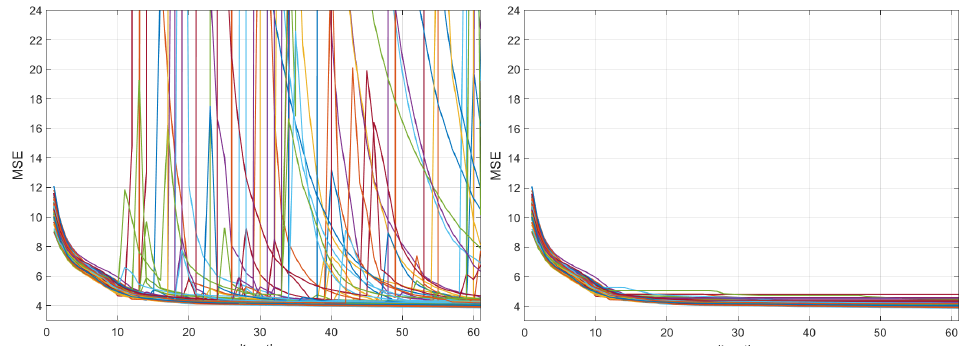
Figure 3. Training MSEs for LBFGS (limited memory Broyden–Fletcher–Goldfarb–Shanno algorithm) on 100 random splits of the abalone dataset, with the different random splits shown in different colors. ( Left ): the training MSEs have many places where LBFGS blows up. ( Right ): considering the minimum train MSE obtained so far at each iteration alleviates the